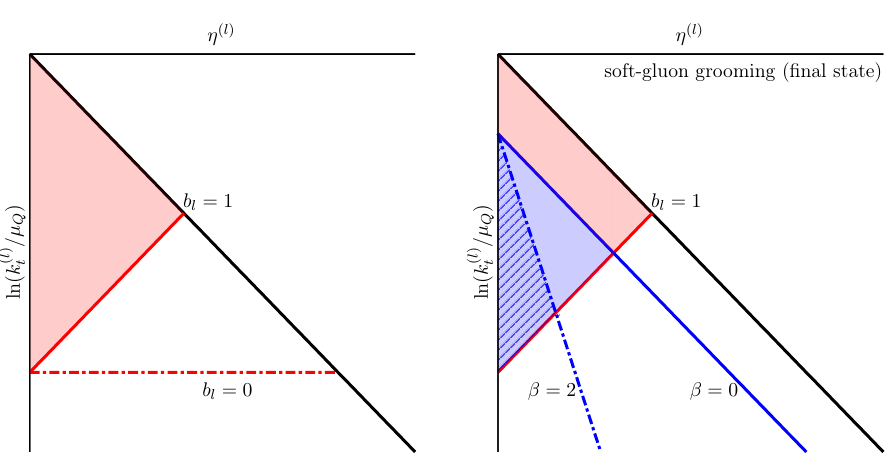
Figure 3 . The emission phase space in the Lund plane illustrating the kinematic constraints without (left) and with grooming (right). In the left figure we consider the C AESAR parameters a l = 1 with b l = 0 and b l = 1 (valid for thrust). The blue areas in the right panel mark the phase-space region removed by grooming with boundaries corresponding to β = 0 (solid line and area) and β = 2 (dashed line, hatched